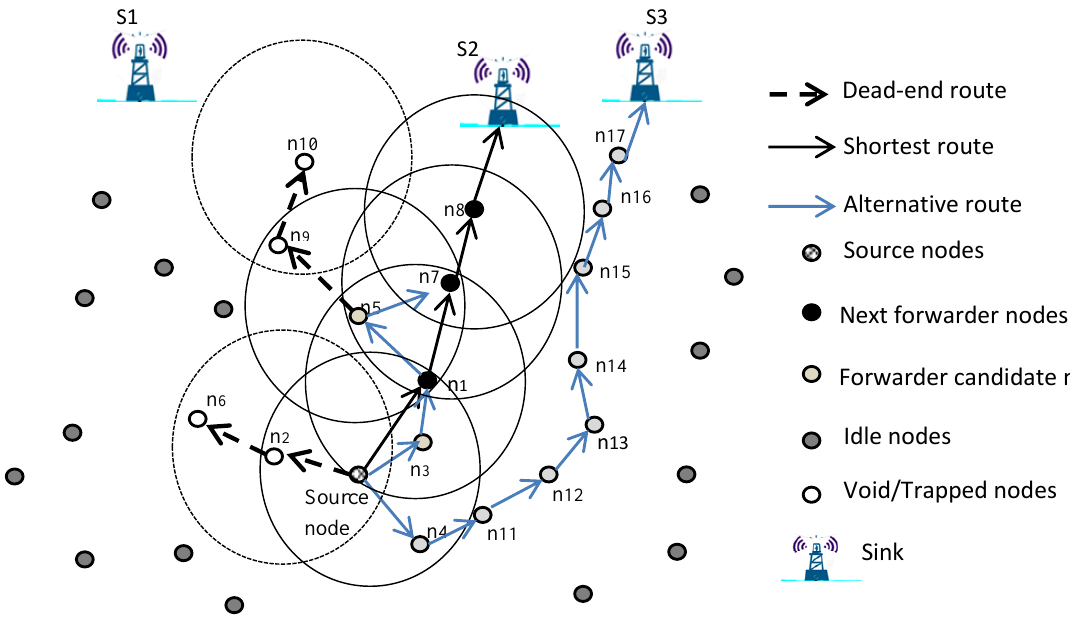
Figure 19. Underwater Network Architecture Model of the EEDOR-VA Protocol.